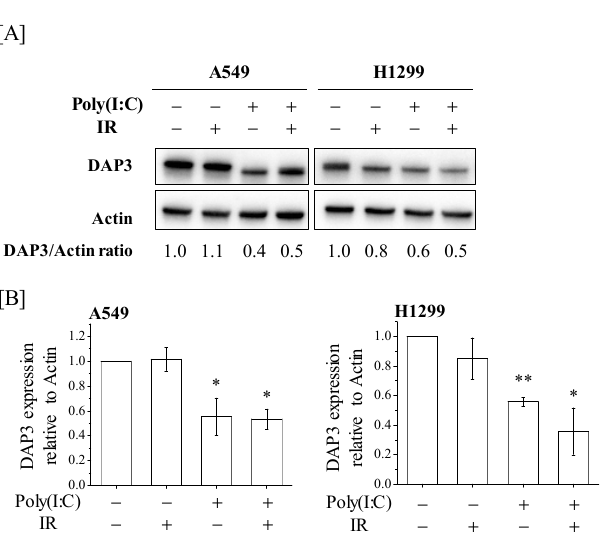
Figure 3. Death-associated protein 3 (DAP3) expression in human lung adenocarcinoma cells treated with Poly(I:C) and/or IR. ( A , B ) A549 and H1299 cells were incubated with Poly(I:C). After incubation for 1 h, the cells were irradiated with 4 Gy. After culturing for 72 h, the cells were harvested for western blotting. ( A ) Representative images of immunoblots are shown. Actin was used as a loading control. ( B ) The relative values of DAP3/actin ratio are presented as mean ± SD of three independent experiments. One sample t -test was performed using the GraphPad QuickCalcs. * p < 0.05, ** p < 0.01 versus control.